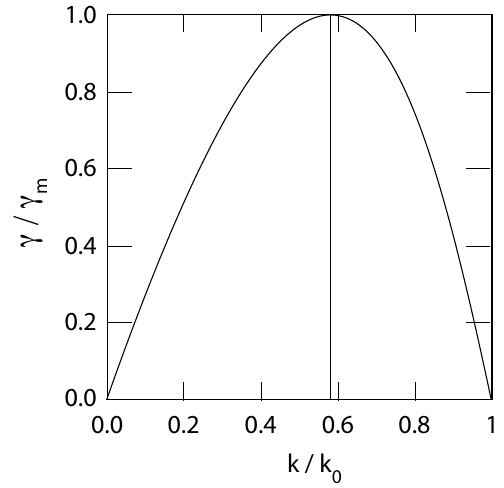
Fig. 1. Dependence of the normalised (to maximum growth γ m ) Weibel growth rate γ on wavenumber. The domain of growing wave numbers is limited by the skin-dpeth wave number k e = ω e /c .